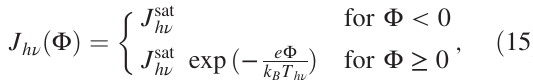
_ Γ ð h ν > 5 eV Þ ¼ 0 . 33 × þ J þ J ¼ 0 e s h ν